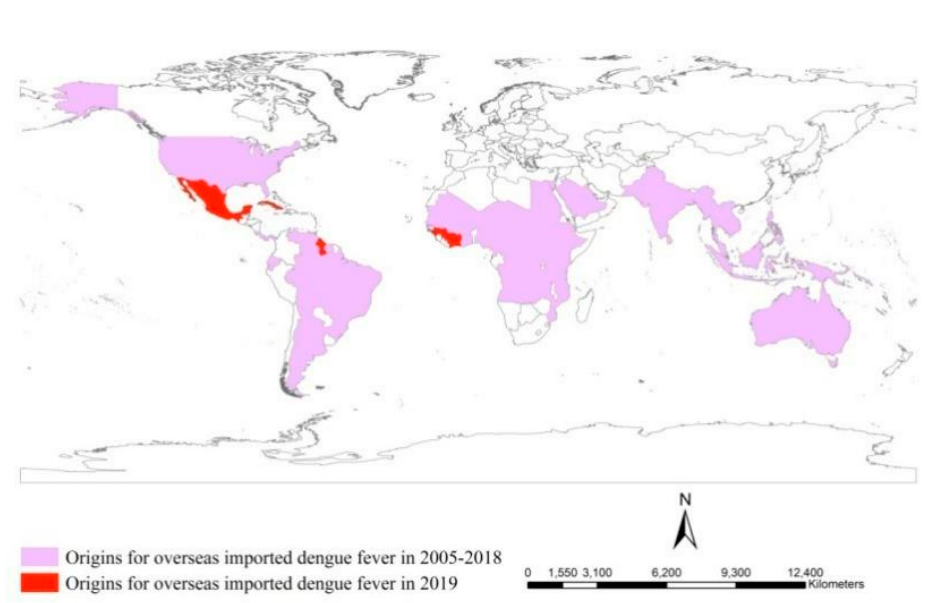
Figure 8. Comparative analysis of overseas imported dengue cases between 2005–2018 and 2019. A total of 79.1% of indigenous cases in mainland China in 2019 were located in Yunnan, Guangdong, Guangxi and Fujian Provinces, all belonging to the southwestern border and southeastern coastal regions. Further, 14.7% of those were located in Chongqing Municipality and Jiangxi Province, both belonging to the central regions. Yearly rainfall in these regions ranges from 800 mm to 1600 mm or even greater than 1600 mm and belong to the torrid and sub-torrid zones [25]. Indigenous dengue fever also occurred in the regions belonging to the warm temperate zone with yearly rainfall of 400–800 mm, such as Henan and Shandong Provinces. Aedes aegypti and Aedes albopictus , the vectors of dengue fever, are distributed in the outer areas along the southwest-northeast line of China, which are much larger than the regions with indigenous dengue fever [26]. The hatching and growth of Aedes aegypti and Aedes albopictus are directly affected by weather conditions such as temperature and rainfall [27]. Furthermore, dengue fever is closely related to the economy, traffic, population mobility, climate warming, Aedes mosquito density and overseas imported dengue fever, etc. [28–31]. Considering the current spatial distribution of dengue fever and mosquito vectors, climate and environmental factors, large